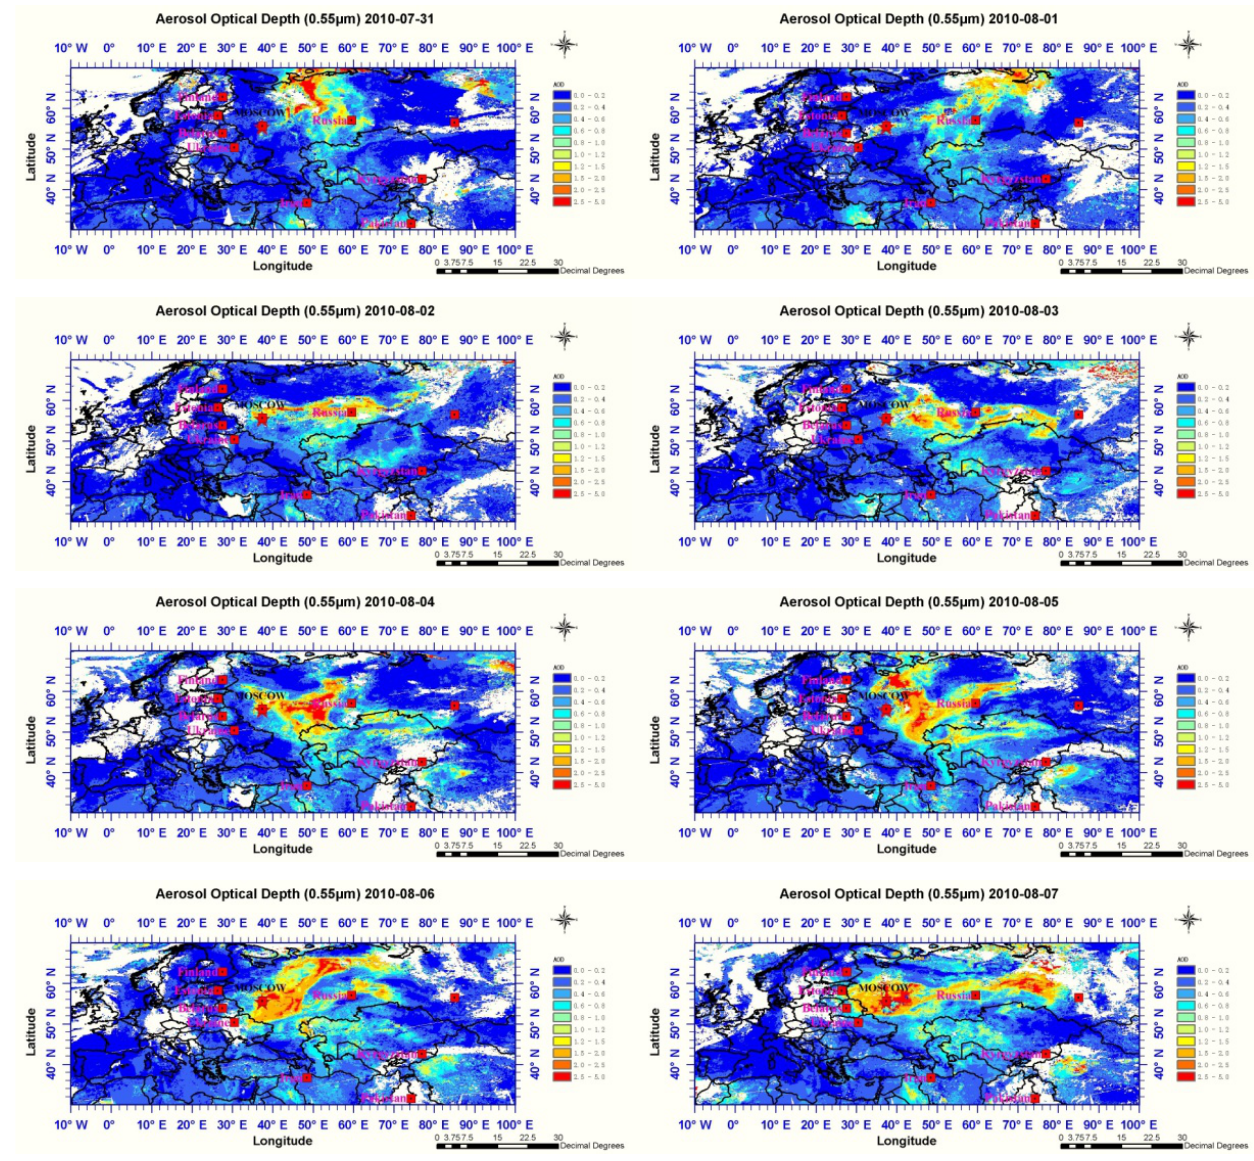
Fig. 4. AOD (at 0.55µm) distribution over the study area for the period from 31 July to 15 August 2010. The AOD was obtained from integration of the AOD retrieved from three different methods as described in the